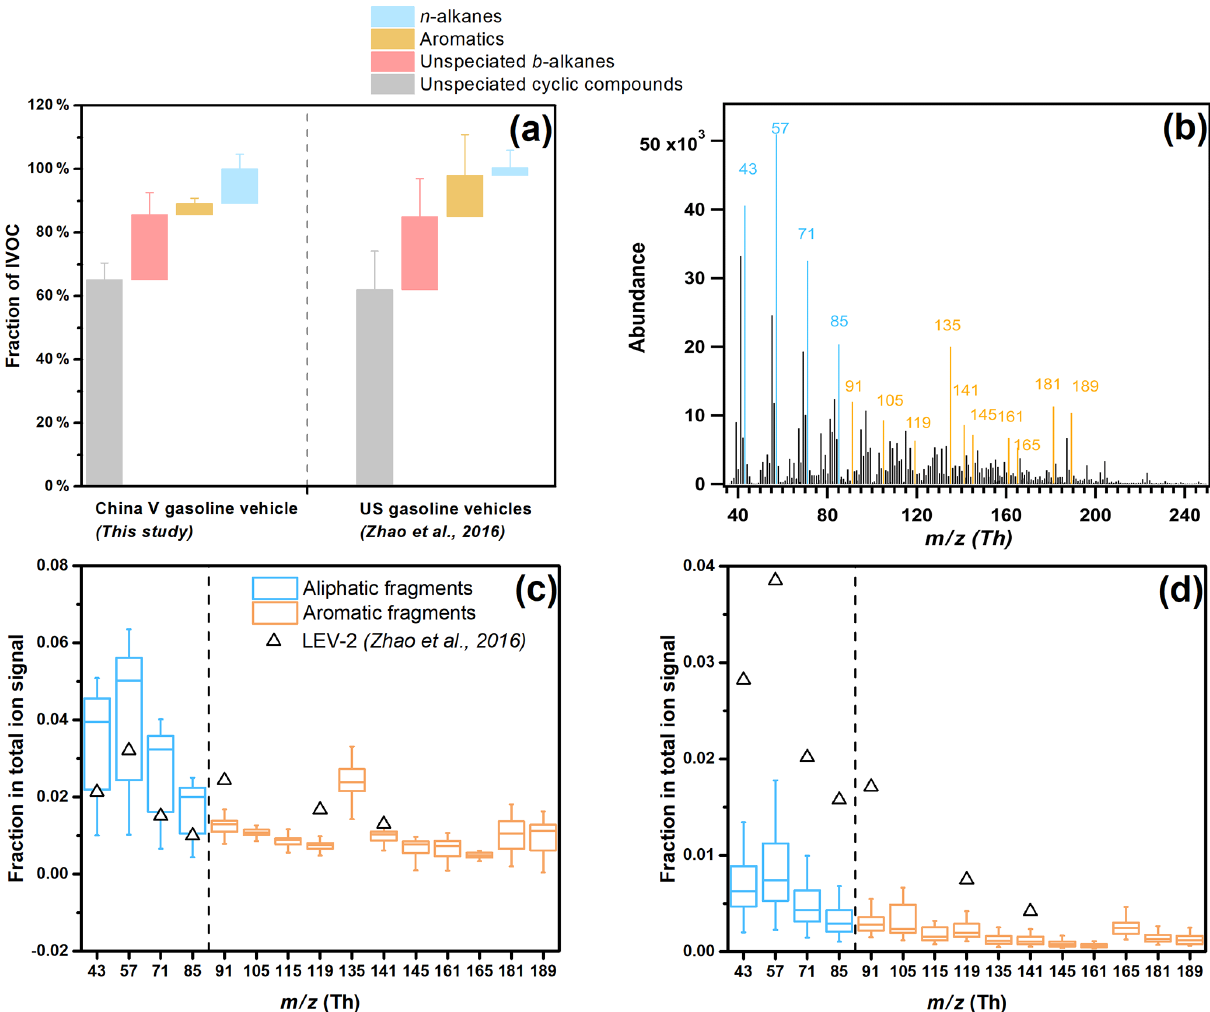
Figure 2. (a) Comparison of average chemical speciation of IVOC emissions from China V vehicles and US vehicles (Zhao et al., 2016). (b) Average mass spectrum of IVOCs during a typical E10-fueled cold-start CLTC test. (c–d) Box-whisker plots of the fractional contribution of selected fragments to the total IVOC signal for the tested China V vehicle: (c) B 12 – B 16 bins and (d) B 17 – B 22 bins. The boxes represent the 25th and 75th percentiles with the centerline being the median. The whiskers are the 10th and 90th percentiles. Black hollow triangles represent median LEV-2 data from Zhao et al. (2016). LEV-2 represents vehicles manufactured from 2004 to 2012. Fragments colored in blue represent aliphatic compounds, while those colored in orange are associated with aromatic